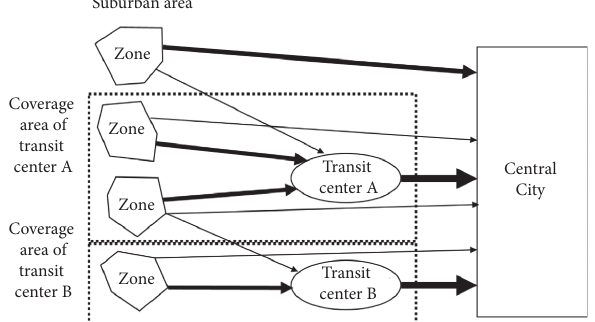
Figure 1: An expanded concept of a coverage area of the transit